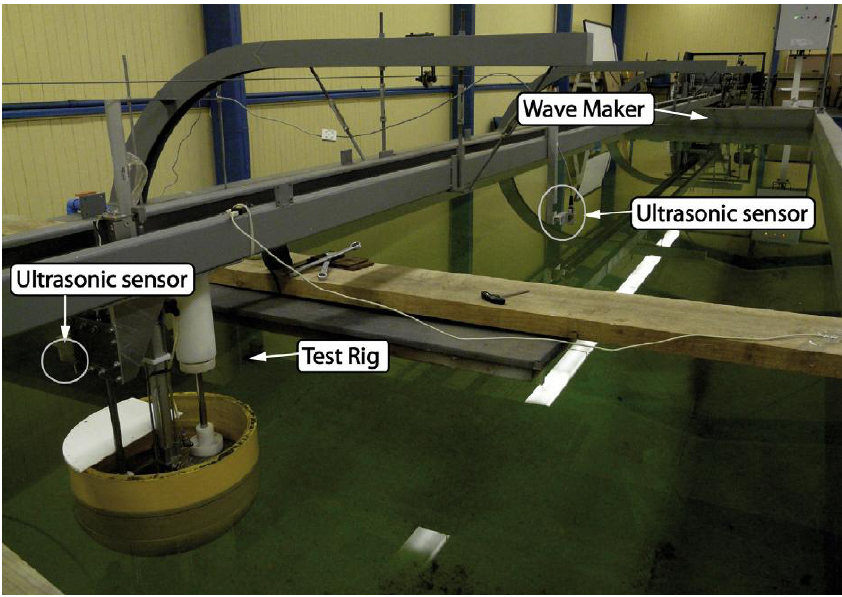
Figure 8. Experimental set-up for a hemispherical buoy in a wave tank [23] .